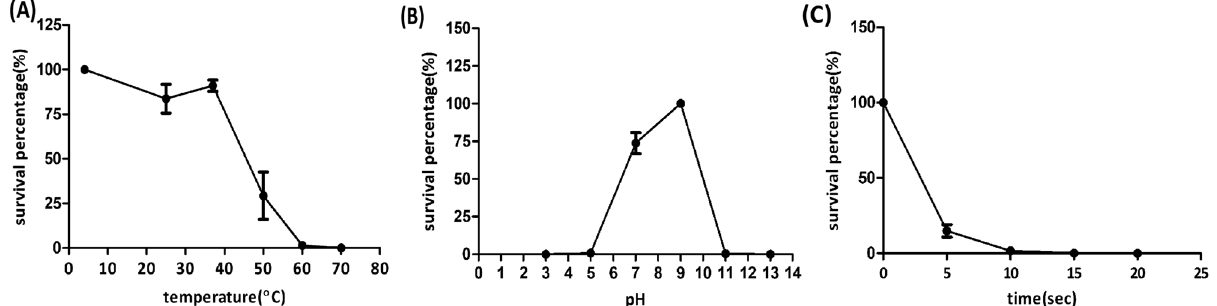
Figure 2. Stability of phage Sfk20: ( A ) Phage thermal stability at different temperature range. ( B ) Phage stability at different pH range, ( C ) Phage stability after UV irradiation.